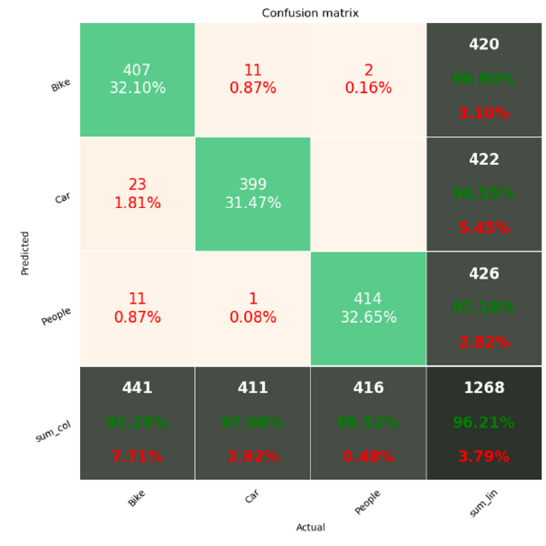
Figure 9. Confusion matrix of proposed system.